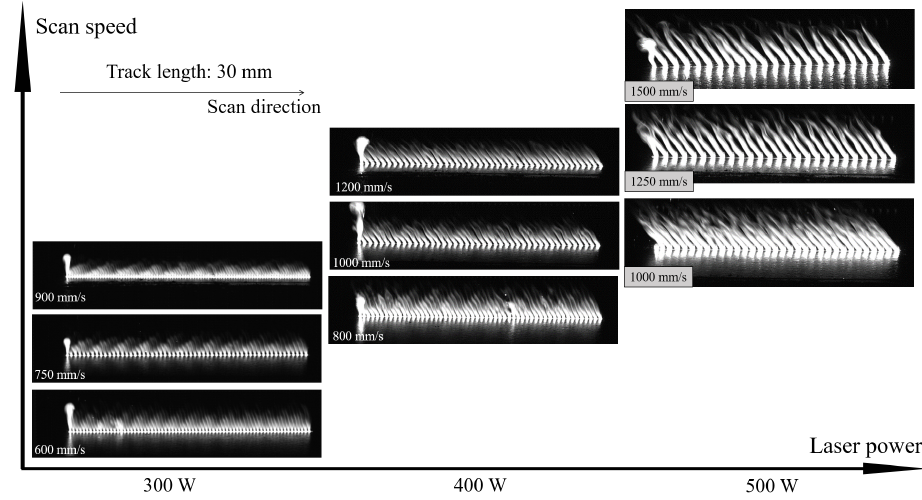
Figure 3. Track-level plume behavior under different laser parameters. Scan direction is from left to right and track length is 30